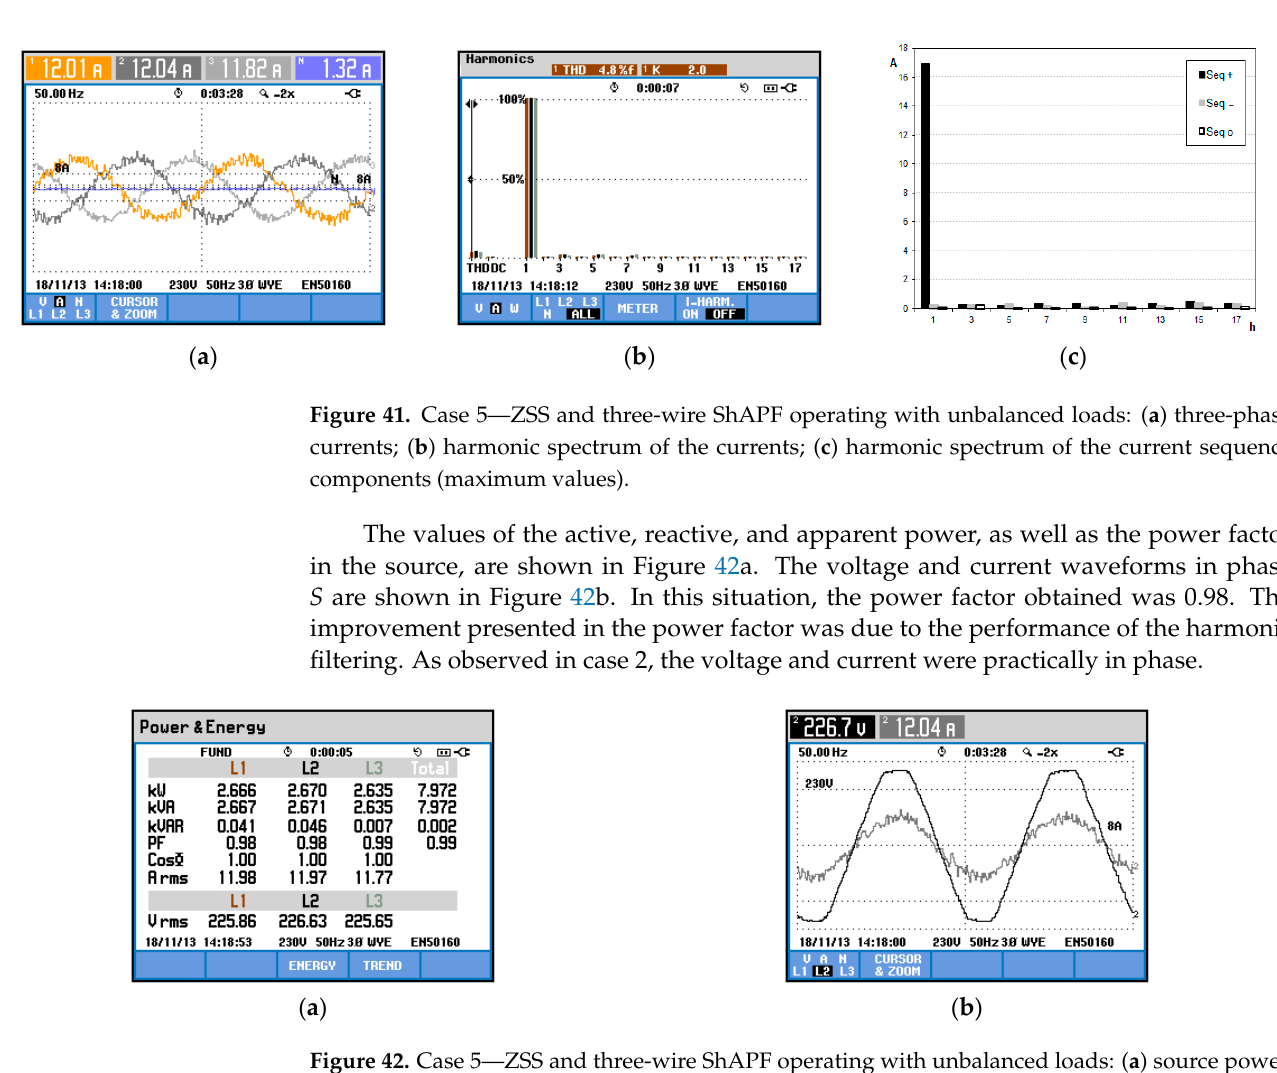
voltages; ( b ) harmonic spectrum of the voltages; ( c ) harmonic spectrum of the voltage sequence